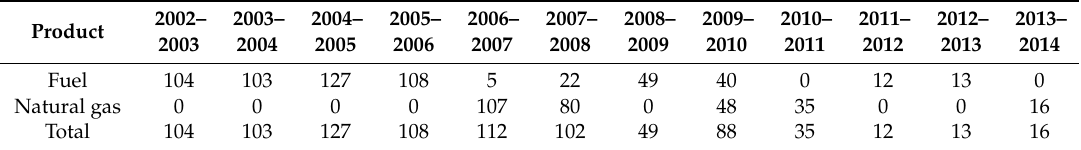
Table 8. Energy used in MWh * between 2002 and 2014. * 1 MWh = 0.086 toe; Source: Field work.